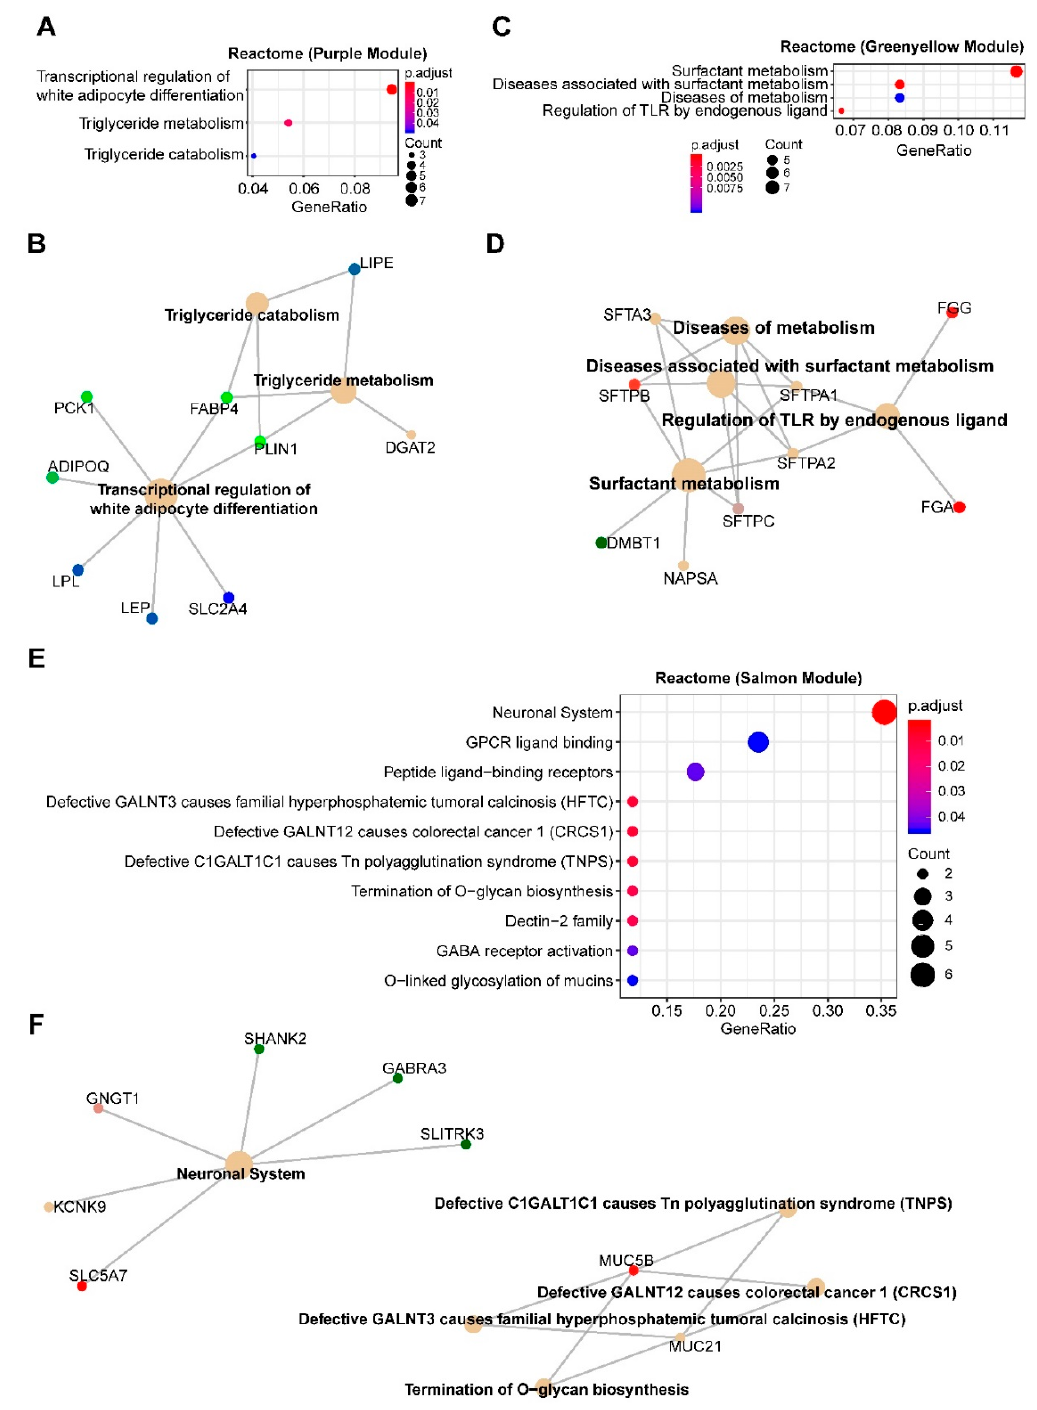
Figure 3. Enrichment analyses of genes significantly correlated with MPM tumors with TP53 alterations. ( A , E ), Significantly enriched Reactome pathways based on genes in the purple ( A , B ), green-yellow ( C , D ) and salmon ( E , F ) modules. Cnetplots in ( B ), ( D ) and ( F ) listed genes in the enriched Reactome pathways ( A , C and E , respectively).